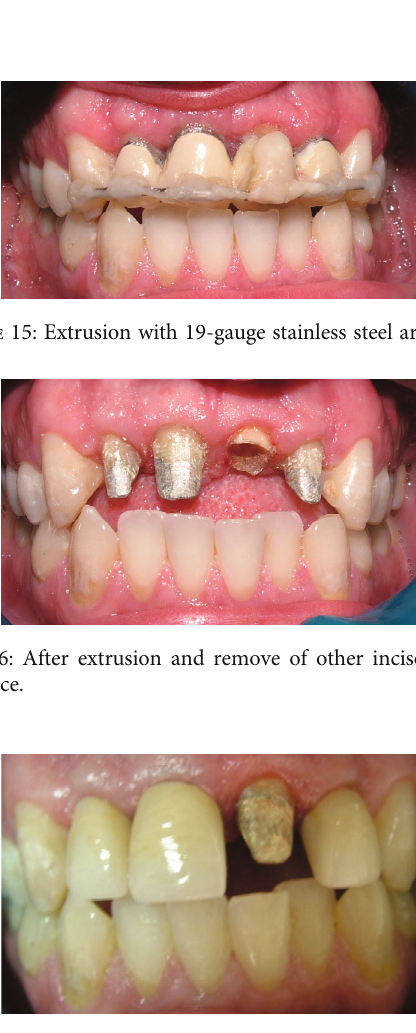
Figure 17: Preparation of cast post.